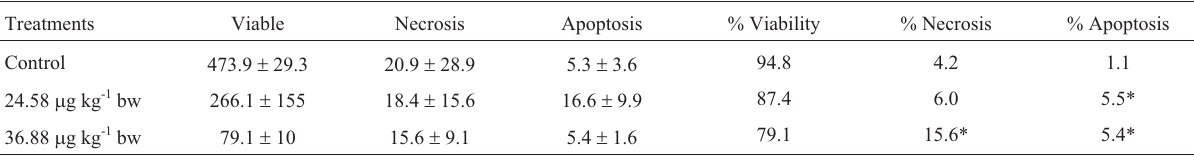
Table 3 - Means (SD) of viables, necrotic and apoptotic peripheral erythrocyte cells of Astyanax bimaculatus and their respective percentages after ip in- jection of extracts of Microcystis spp.